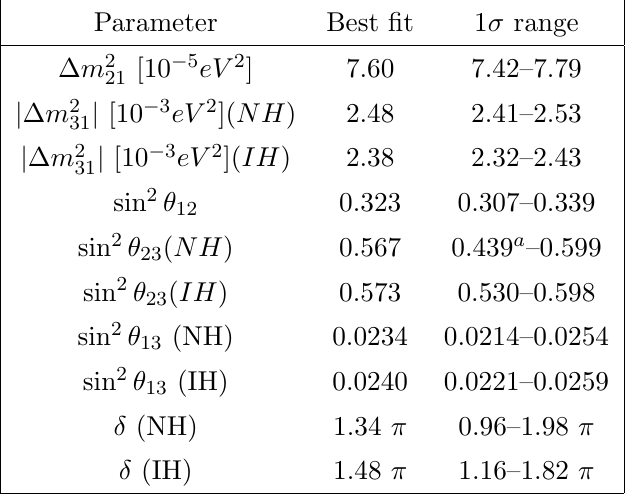
, sin 2 (cid:18) 23 , sin 2 (cid:18) 13 , 31